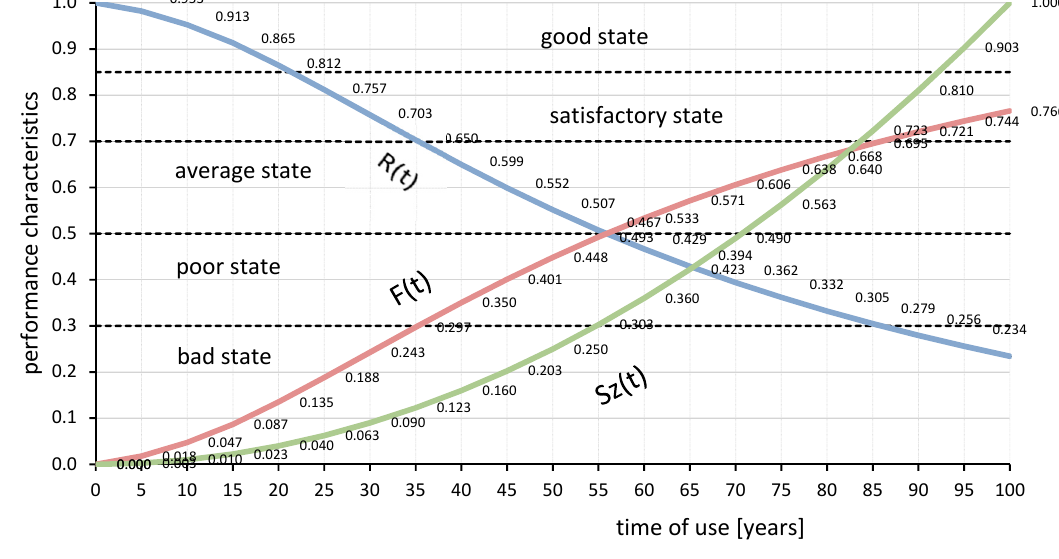
Figure 1. Functions describing the aging process of a building.